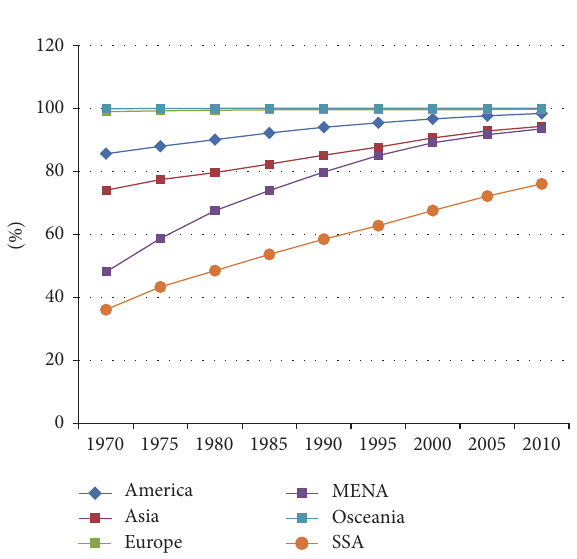
Figure 5: Share of females (15–24) with at least some primary education (lower secondary education and above), by